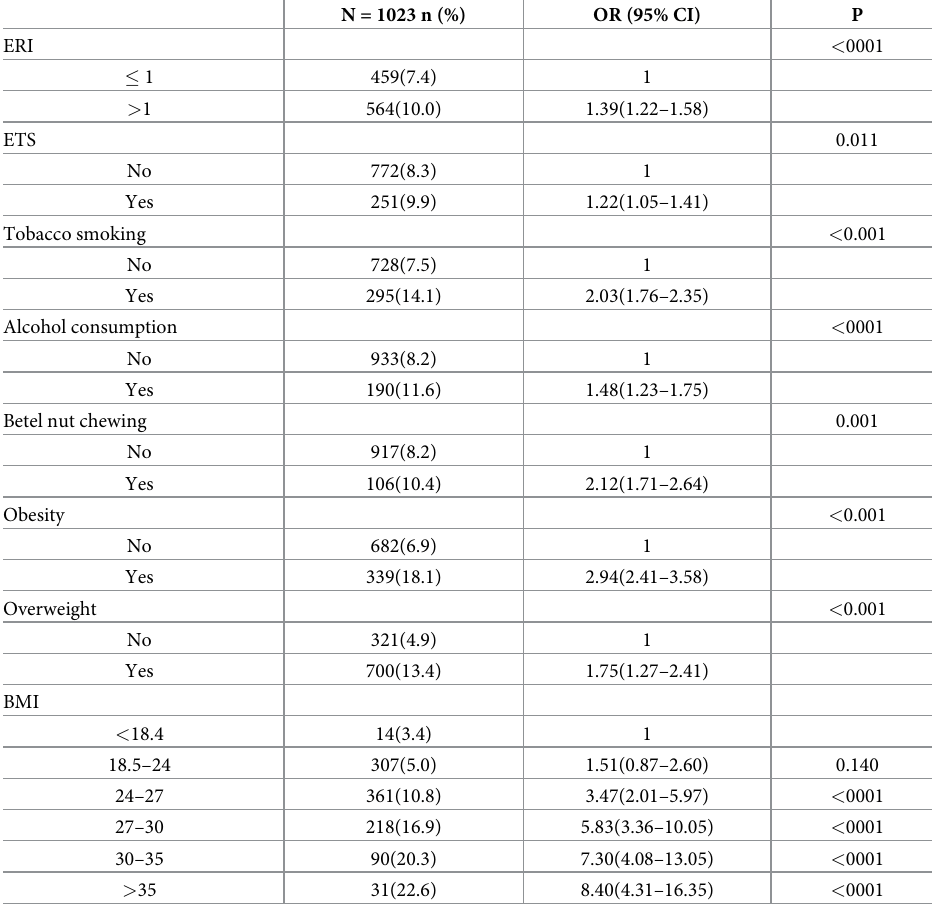
Table 2. Univariate analysis of hyperlipidemia and risk